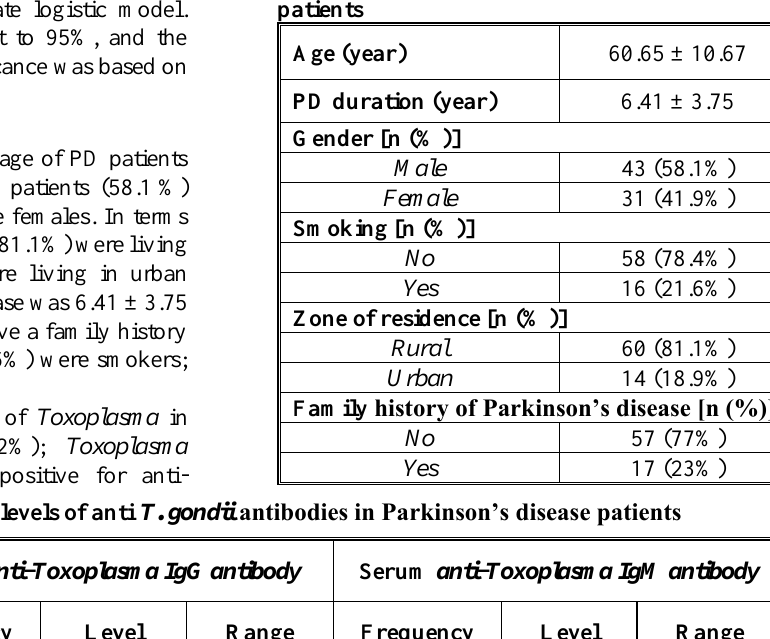
Table 1. Characteristics of 74 Parkinson’s disease